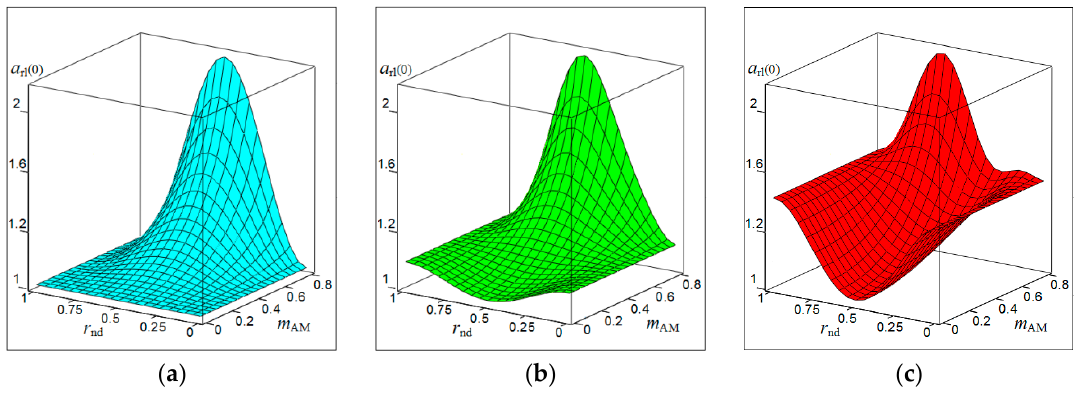
Figure 1. Characteristics of the amplitude selection (CAS) a rl ( 0 ) of the autodyne signal on the variation of the oscillation amplitude with AFM on the zero harmonic of the modulation frequency calculated for di ff erent values of k FM : ( a ) k FM = 0, ( b ) k FM = 0.4, and ( c ) k FM =